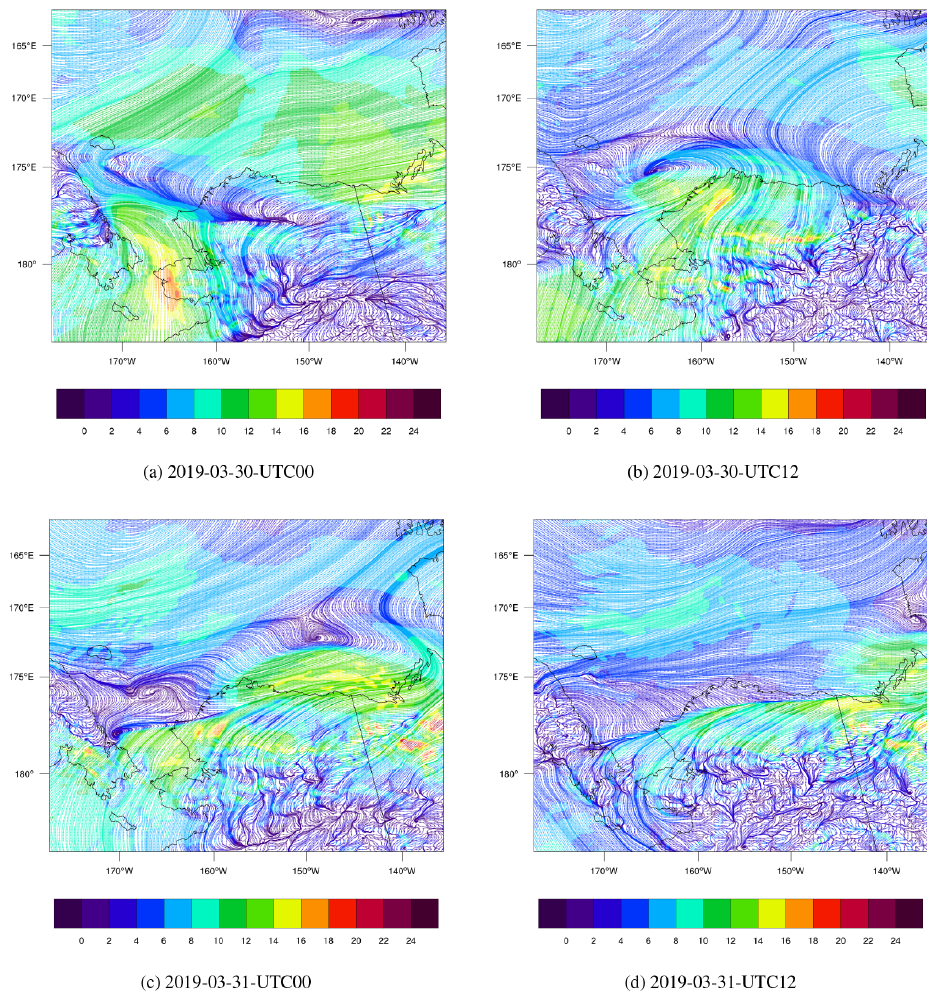
Figure 6. The spatial distribution of surface wind (ms − 1 ) and the streamline simulated by WRF from 30 to 31 March 2019.